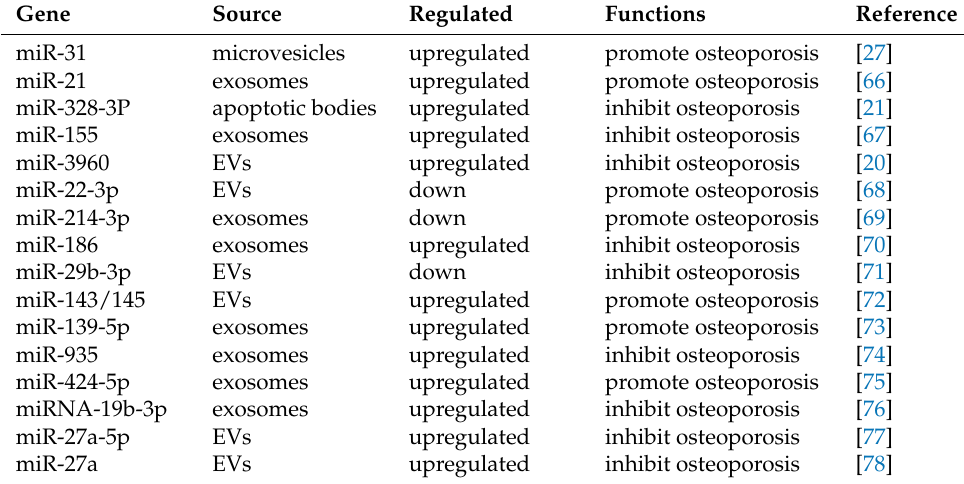
Table 3. The role of EV-associated miRNA in osteoporosis.